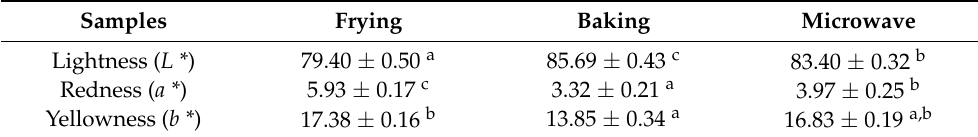
Table 1. Physiochemical properties of fish meat-based snacks prepared by various processing methods.